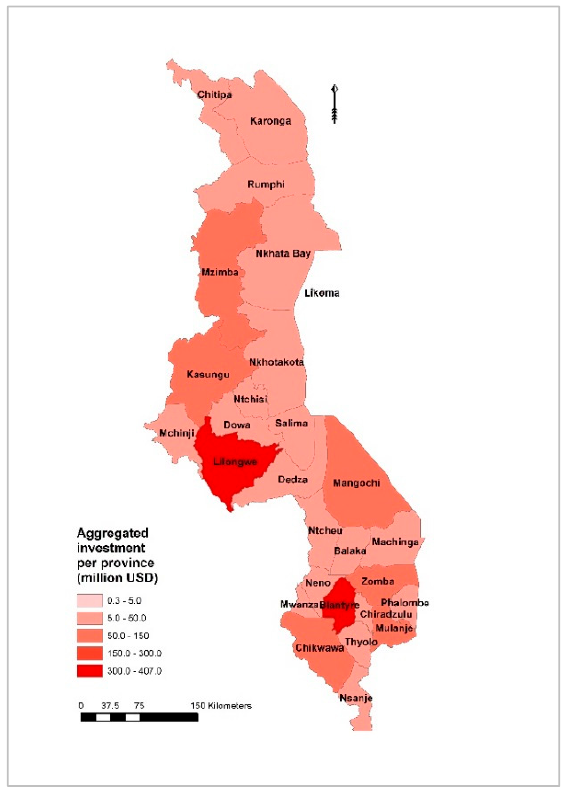
Figure 10. Investment requirements for the achievement of universal access as defined in the selected electrification scenario for Malawi by 2030. Results are aggregated per province.